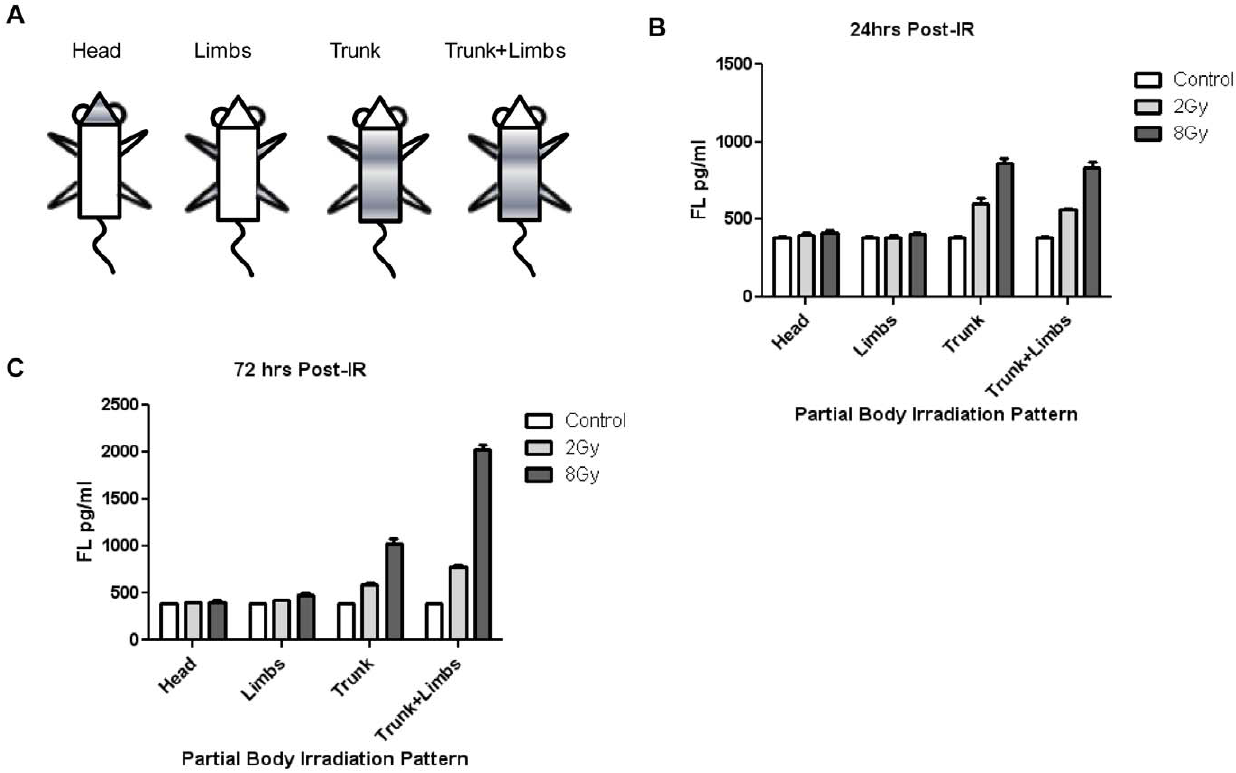
Figure 2. Partial Body Irradiation Patterns and FL Response. Plasma FL expression following heterogeneous partial body irradiation patterns in C57BL6 mice. A) Mice were partially shielded to irradiation using the represented partial body diagrams with either the head, limbs, trunk, or trunk + limbs exposed. B) Plasma FL expression in partial body exposed mice at 0, 2, and 8 Gy at 24 hrs post-IR. C) Plasma FL expression in partial body exposed mice at 0, 2, and 8 Gy at 72 hrs post-IR. Values reflect the mean 6 SEM.